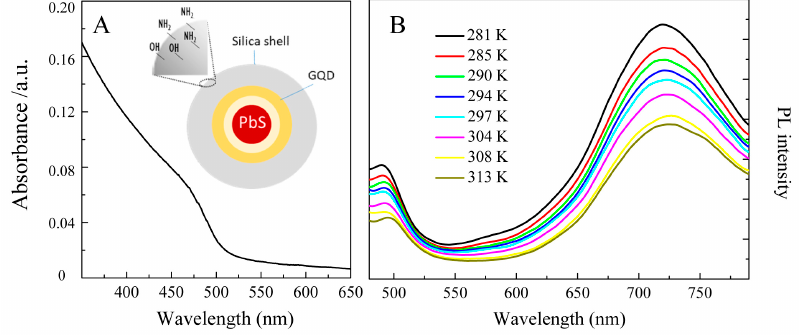
Figure Figure 4. UV-Vis absorption (A) and fluorescence spectra in a 281 − 333 K temperature range (B, λ ex = 400 nm) of silica coated GQDs NPs. A sketch of the nanostructure is shown in panel A.